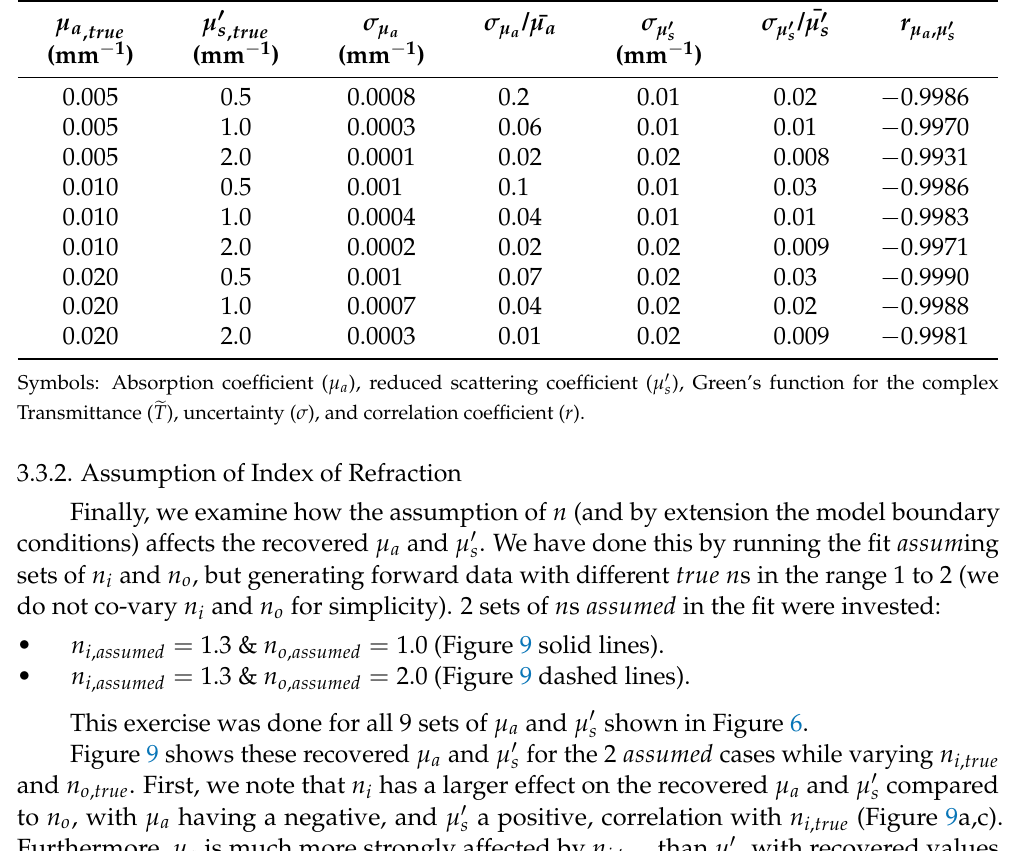
/ ¯ µ a σ µ (cid:48) σ µ a